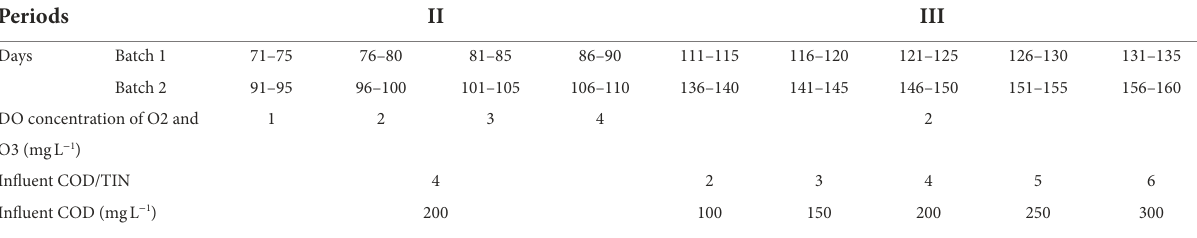
TABLE 3 Operation parameters of the reactor during periods II and